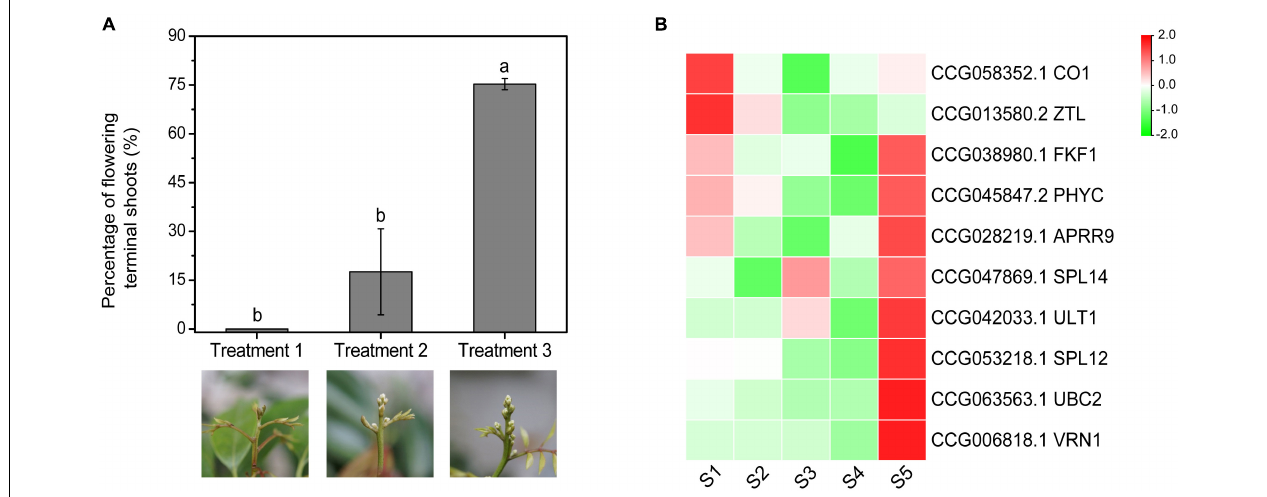
FIGURE 7 | Effects of gradient chilling treatments on flowering (A) and CAG expression (B) of litchi trees. ‘Guiwei’ potted trees were grown in a growth chamber at 10 ◦ C for floral induction. The trees were transferred to a growth chamber at 22 ◦ C after 5, 7, and 9 weeks, respectively. Different letters indicate significant differences at p < 0.05 among the treatments according to Tukey’s multiple range test. S1, S2, S3, S4, and S5 indicate the time points of 0, 21, 35, 49, and 63 days of